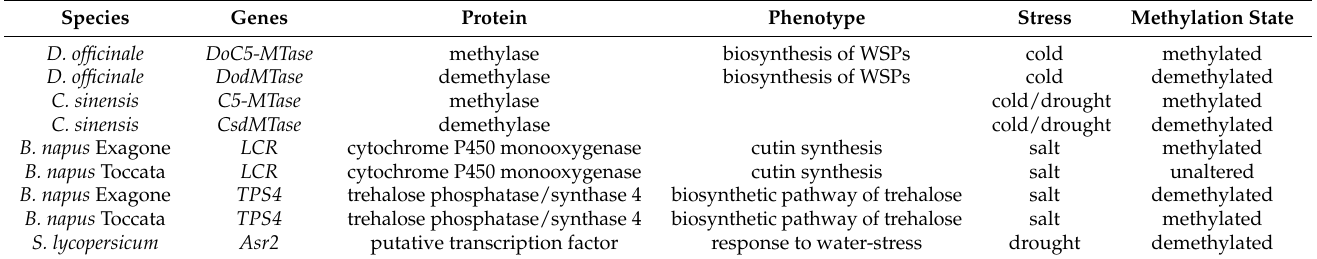
Table 1. Summary of the genes that change the methylation levels in response to abiotic